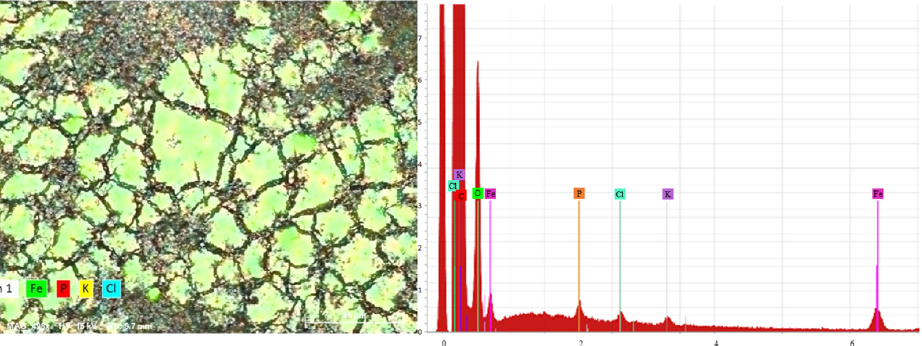
Figure 6. Surface element analysis of ferrate (VI) resultant particles after ferrate (VI) treatment of ATP in distilled water. (P = 500 μ g/L; Fe (VI) = 5.0 mg/L; pH = 6.5). ATP in distilled water. (P = 500 µ g/L; Fe (VI) = 5.0 mg/L; pH = 6.5).